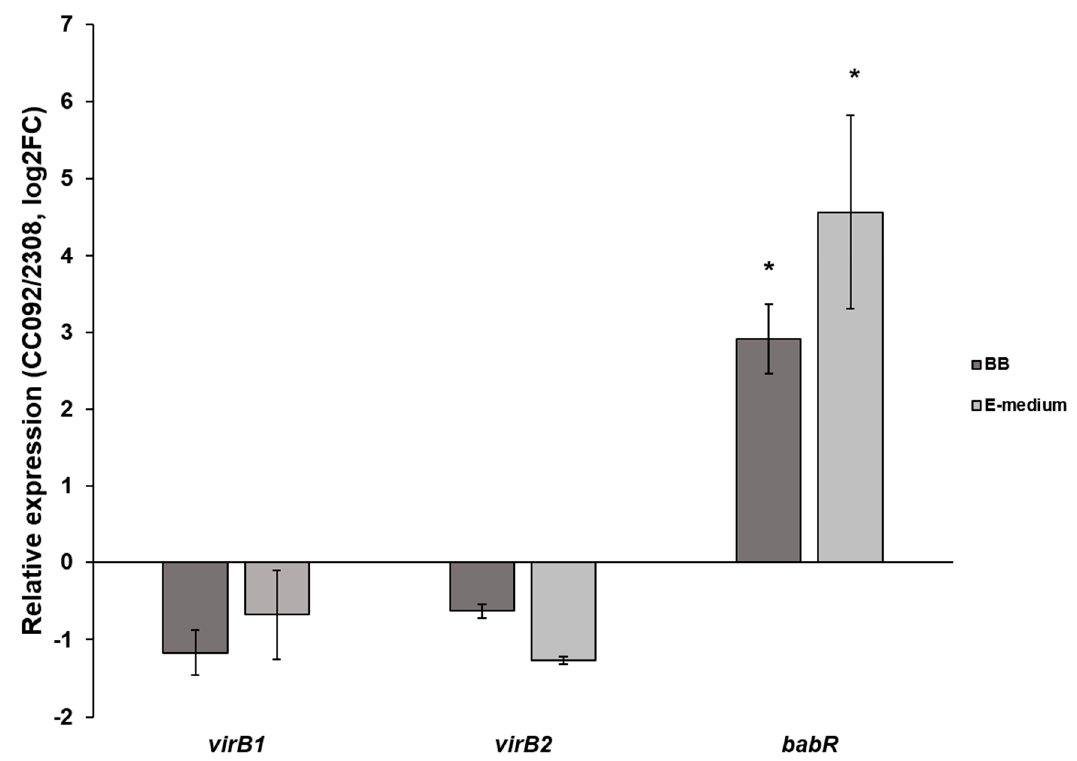
Figure 6. Relative expression of virB1 , virB2 and babR in B. abortus 2308 (solid bars) and CC092 (hashed bars) after growth in Brucella broth (BB) or upon exposure to a virulence-inducing condition (E-medium). Asterisks indicate significant difference in relative expression ( p value < 0.05) as determined by one sample t-test. The p value in the case of bars without asterisk is > 0.05.